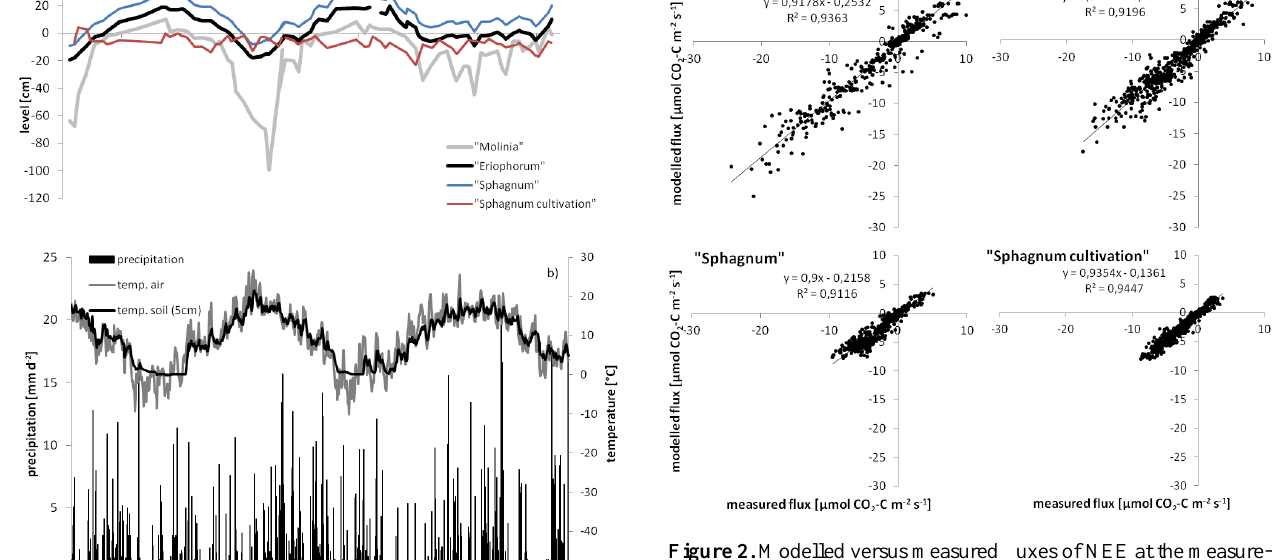
Figure 2. Modelled versus measured fluxes of NEE at the measure- ment sites. Regression equations and coefficients of determination (Pearson) ( R 2